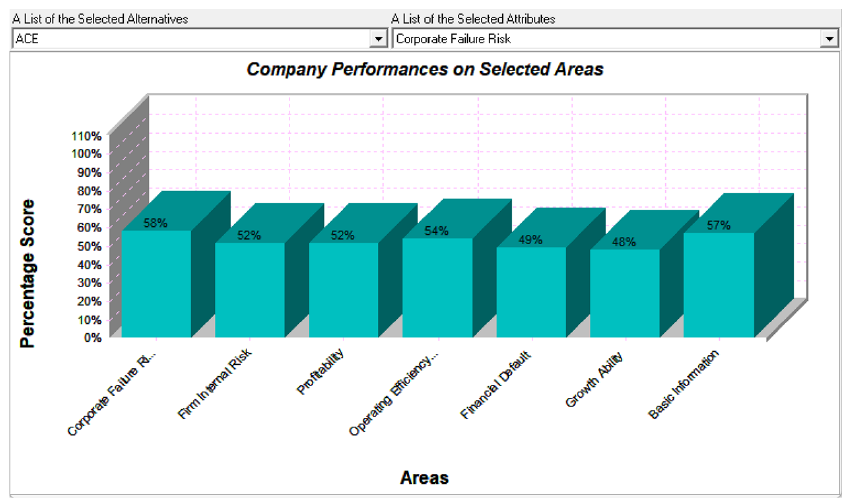
Figure 8. The assessment of one company in detail.